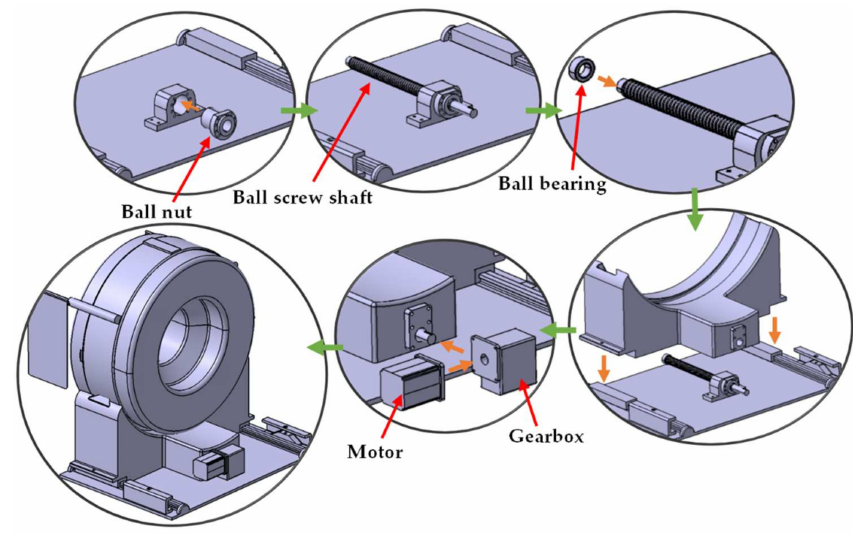
Figure 10. Assembly of concept CT scanner model.